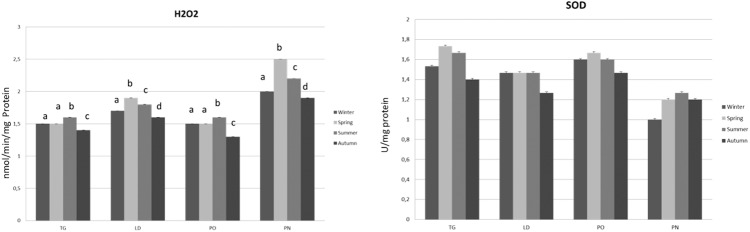
Hydrogen peroxide (H2O2) and SOD (Superoxide Dismutase) of M. galloprovincialis collected at the different sites and periods. Different superscripted letters indicate statistically significant differences (P < 0.05).